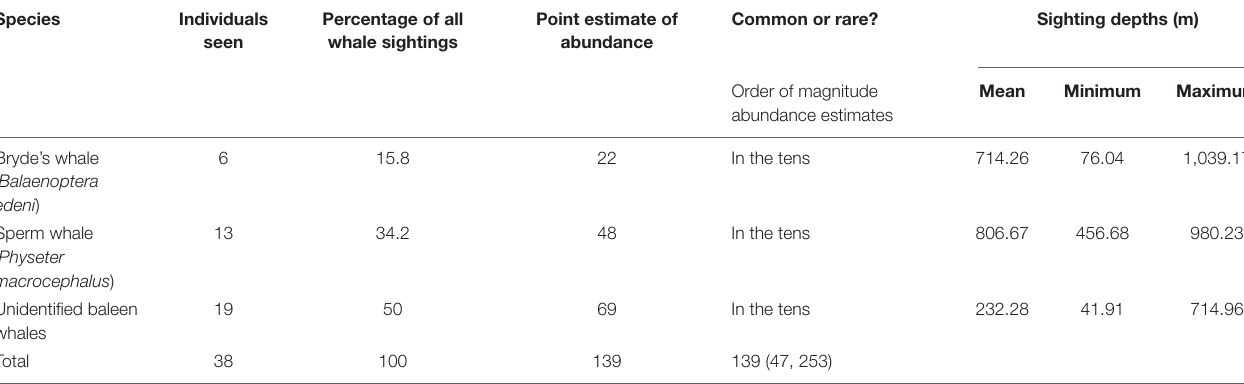
TABLE 1 | Number of sightings used in the detection function analysis for each whale species along with their predicted relative abundance and associated depths in the surveyed region.